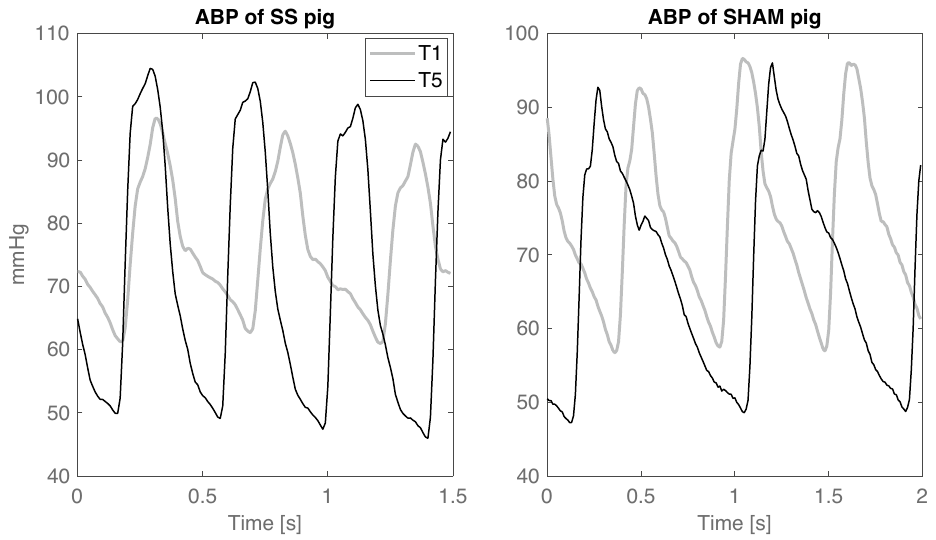
Figure 6. Example of carotid arterial blood pressure waveform of a septic pig and a sham pig, at T1 (baseline) and T5 (72 h after the start of